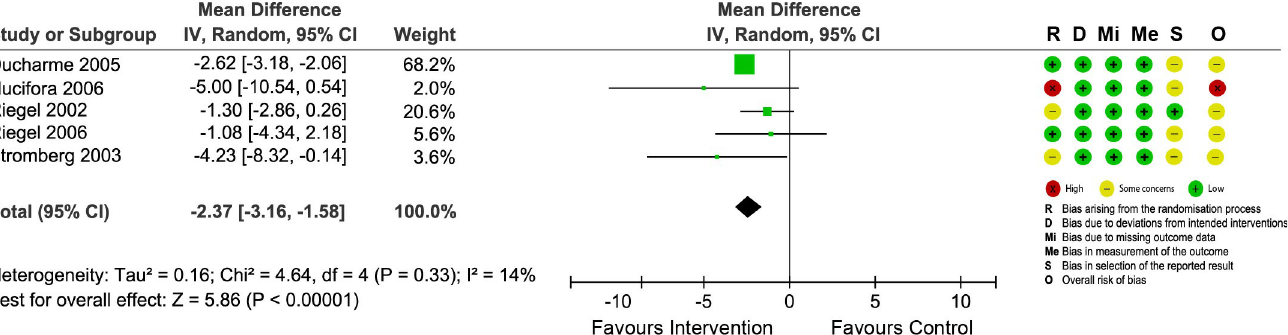
Fig 5. Forest plot showing the effect of nurse-led TCIs on the length of hospital stay and risk of bias assessment for each study.